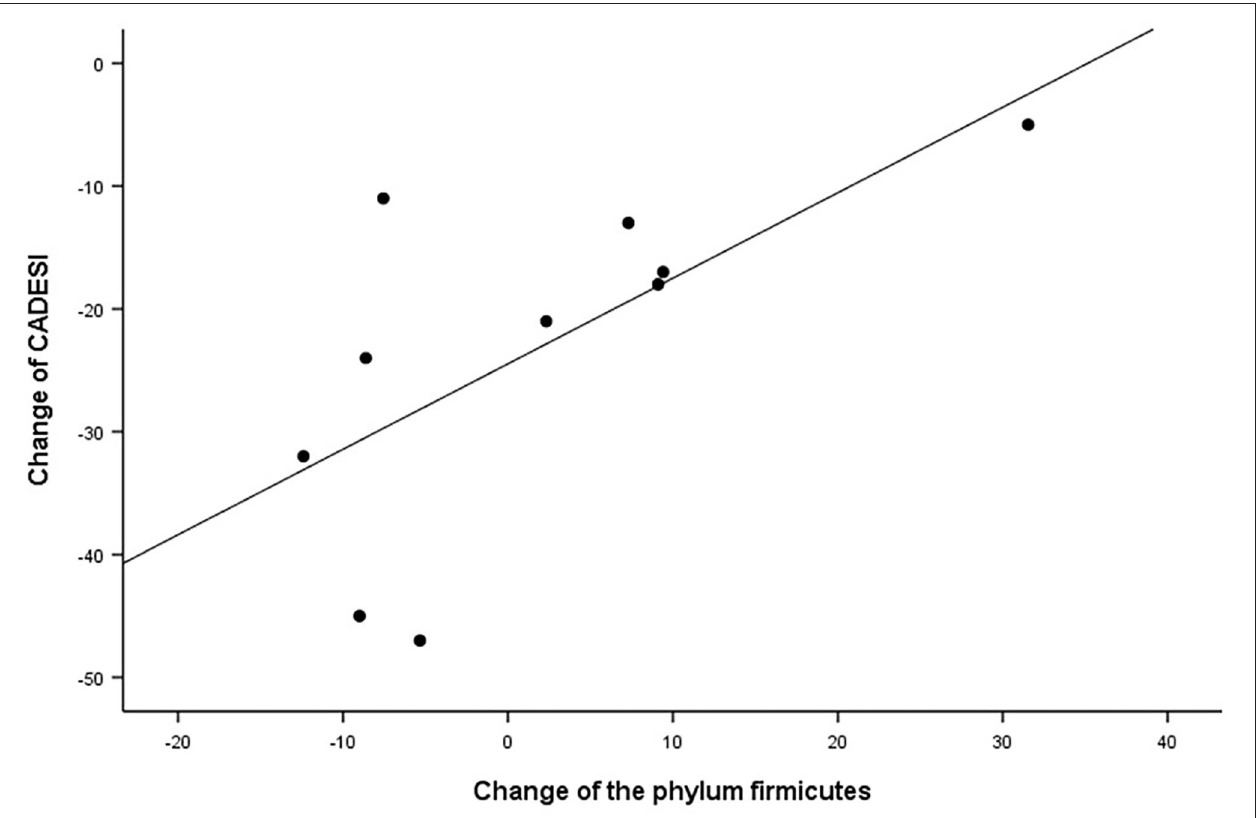
FIGURE 10 | Correlation analysis. Correlation between the CADESI and change in relative abundance of the phylum Firmicutes in the allergic group after excimer light therapy. CADESI, canine atopic dermatitis extent and severity index.